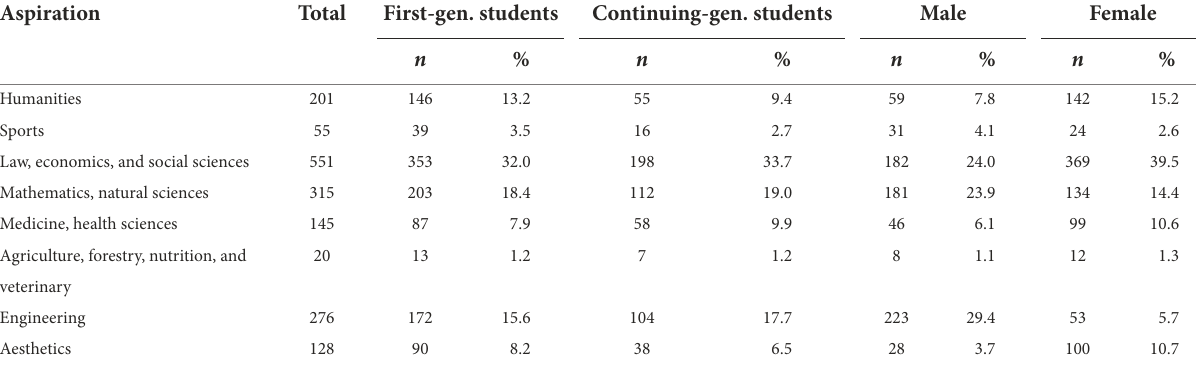
TABLE 1 Frequencies of first-generation, continuing-generation, female, and male students’ study program aspirations.